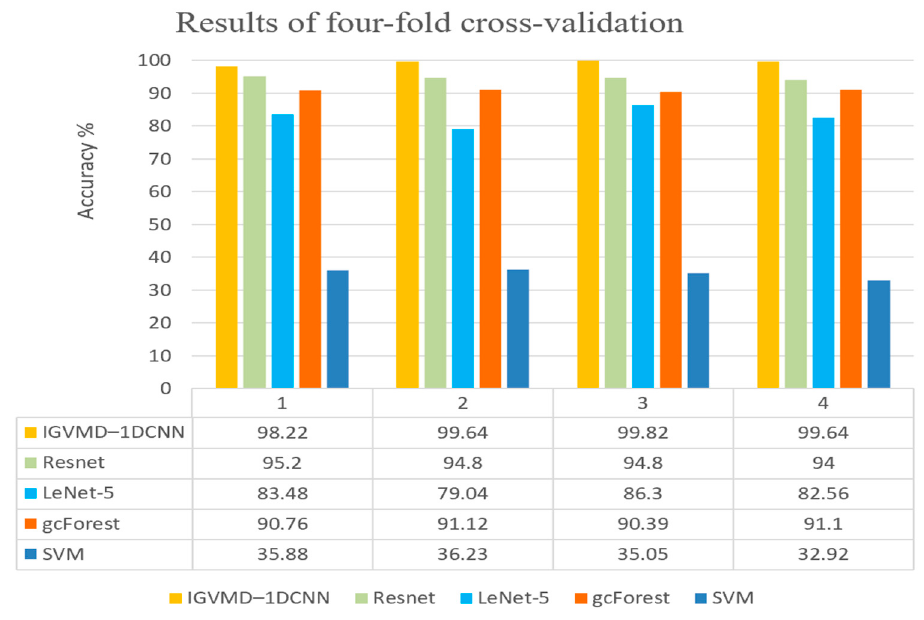
Figure 24. The cross-validation results of different models. Table 9. Comparison results with the different models using the gearbox dataset.